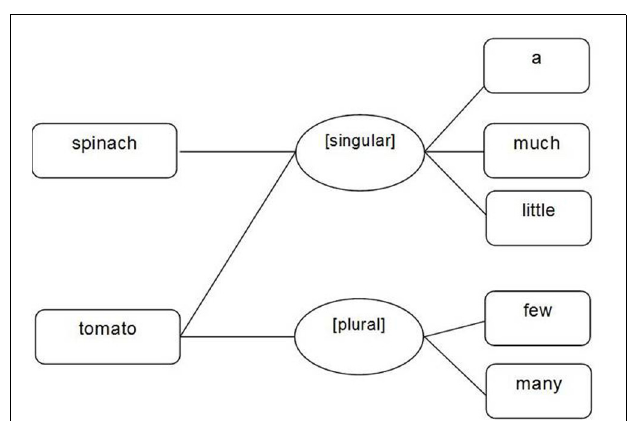
FIGURE 5 | Representation of mass nouns (e.g., spinach) and count nouns (e.g., tomato) at the lexical-syntactic (lemma) level according to Levelt